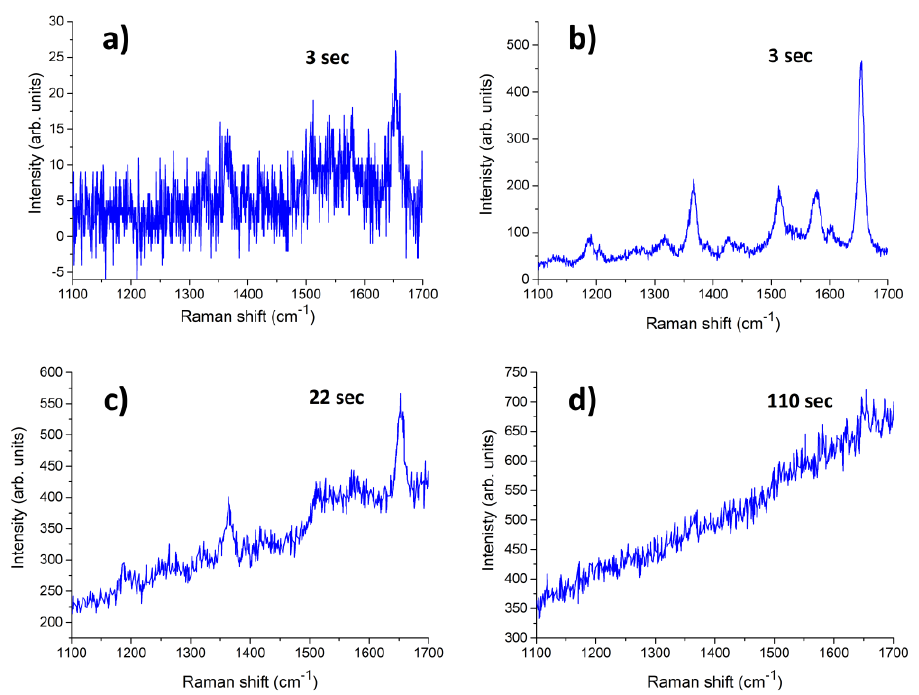
Figure 18. ( a ) Raman spectrum of R6G (10 − 4 M solution.) drop cast on glass and ( b – d ) Time-dependence of the SERS spectra of R6G (10 − 4 M solution) A drop of 10 − 4 M water solution of R6G was cast on the glass and dried in air before measurements; the Raman spectra were acquired using an HR800 micro-Raman spectrometer (Horiba, Jobin-Yvon, Longjumeau, France), using the 457.9 nm line of an Ar + ion laser, setting the laser power at 1 mW. The integration times were varied from a few seconds up to 110 seconds to maximize the signal to noise ratio.